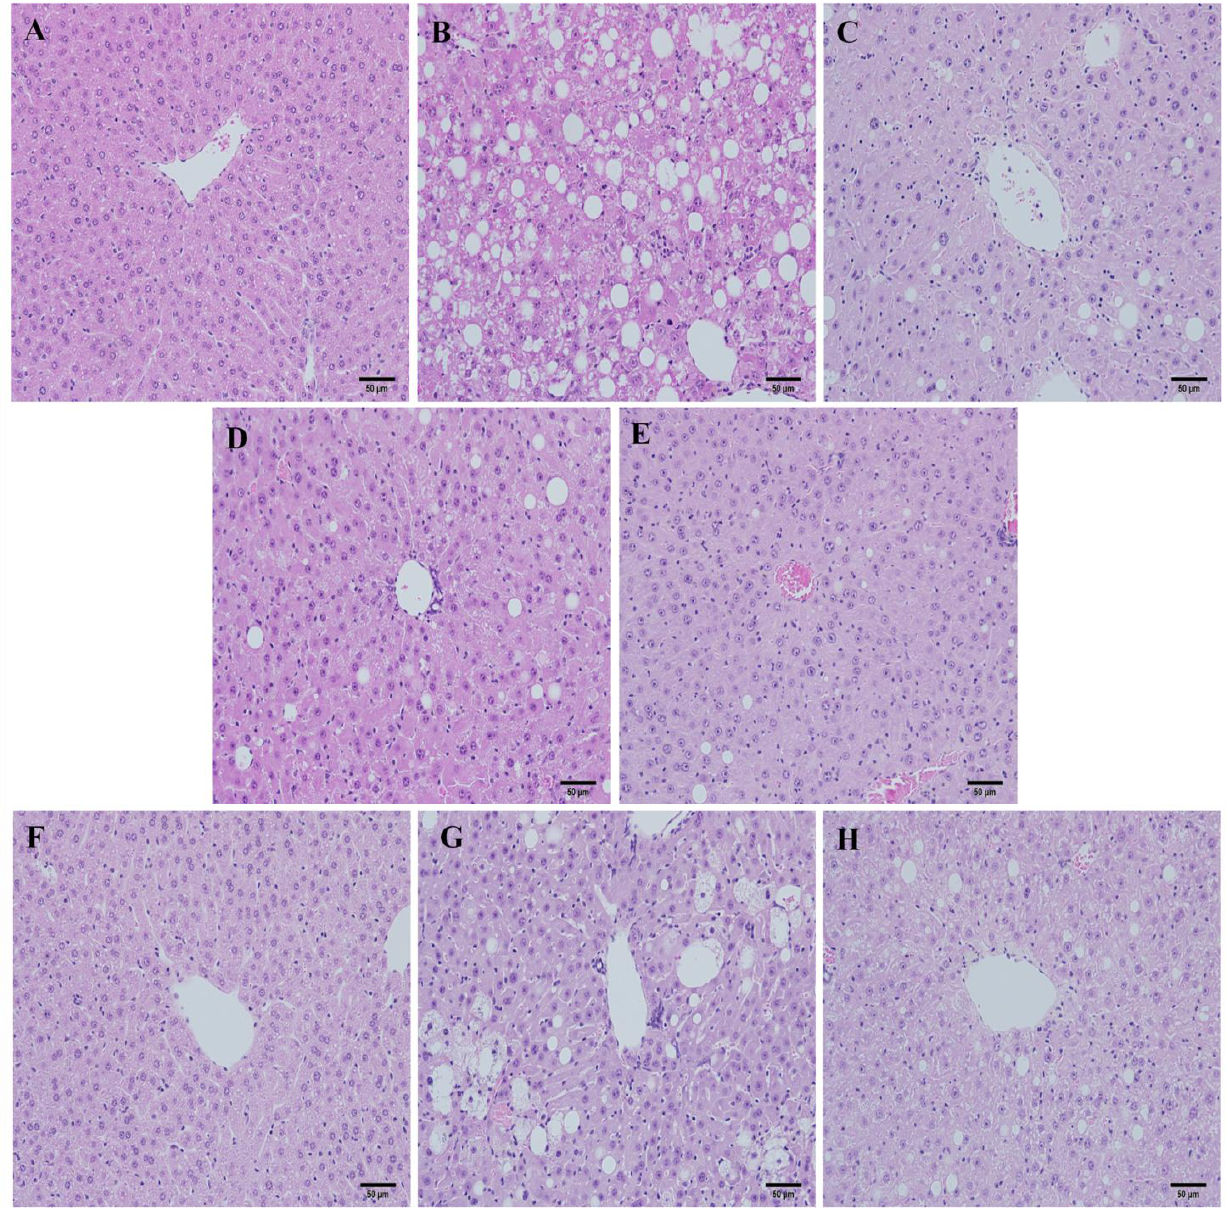
Figure 2. Effects of SME administration on NASH induced by the MCD diet in liver sections stained with H&E. ( A ) Normal group (normal diet only); ( B ) Control group (MCD diet only); ( C ) Low-dose group (SME; 0.1 mg/kg/day); ( D ) Mid-dose group (SME; 0.5 mg/kg/day); ( E ) High-dose group (SME; 1 mg/kg/day) for 4 weeks (magnification ×200) and ( F ) Normal group (normal diet only); ( G ) Control group (MCD diet only); ( H ) Low-dose group (SME; 0.1 mg/kg/day); ( I ) Mid-dose group (SME; 0.5 mg/kg/day); ( J ) High-dose group (SME; 1 mg/kg/day) for 6 weeks (magnification ×200); ( K , L ) Sections were evaluated in a blinded manner by pathologists, and a scoring method was assigned as described in experimental methods for NASH (NAFLD Activity Score) evaluation. Data are expressed as mean ± SD, * p < 0.05 vs. MCD diet only; ** p = 0.0004 vs. MCD